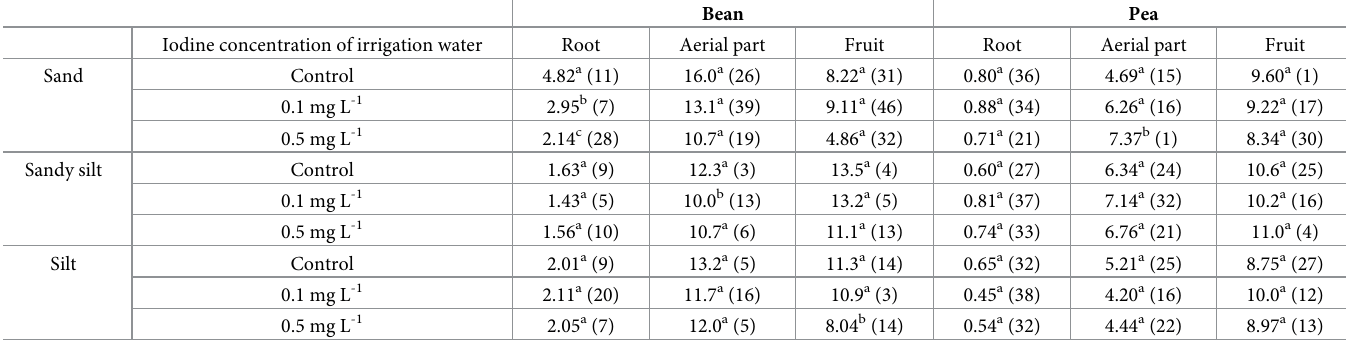
Table 5. Effect of iodine treatments on the dry mass (g) of different plant parts. Data show the mean of three replicates (RSD%). The different letters show statistically significant differences between the treatments ( p < 0.05, linear regression, Tukey’s test). Bean Pea Iodine concentration of irrigation water Sand